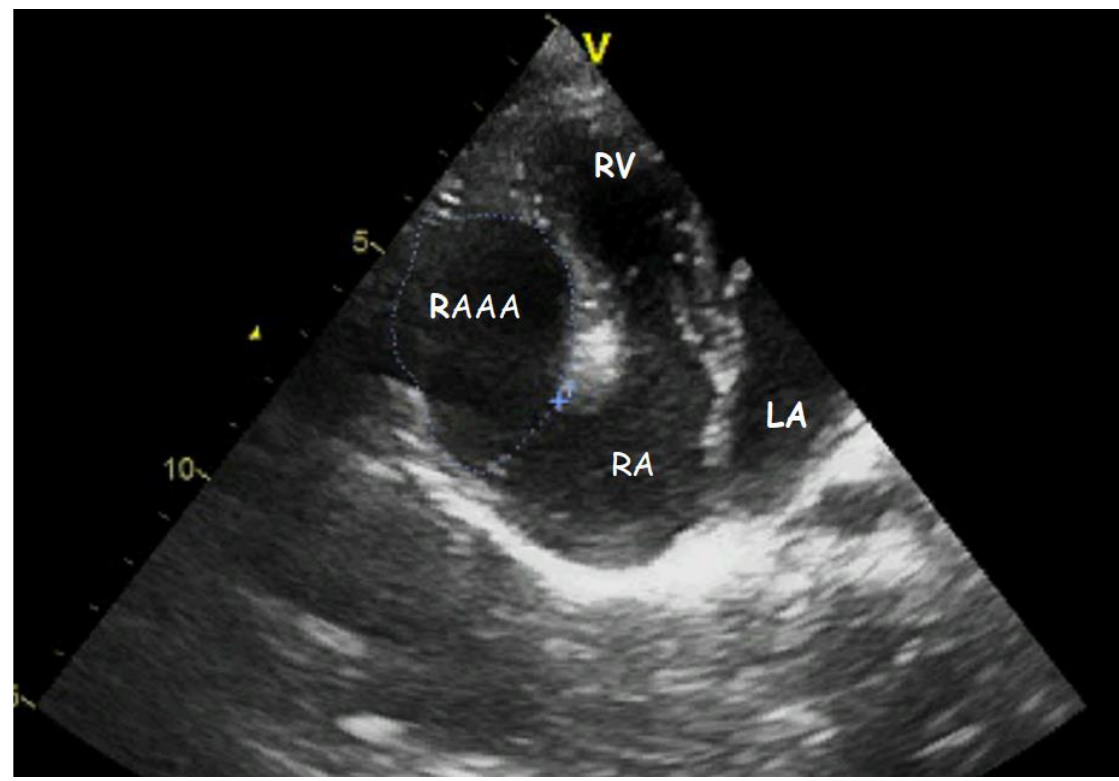
Figure 1. Transthoracic echocardiogram. Modified four − chamber view showing the gigantic RAAA.